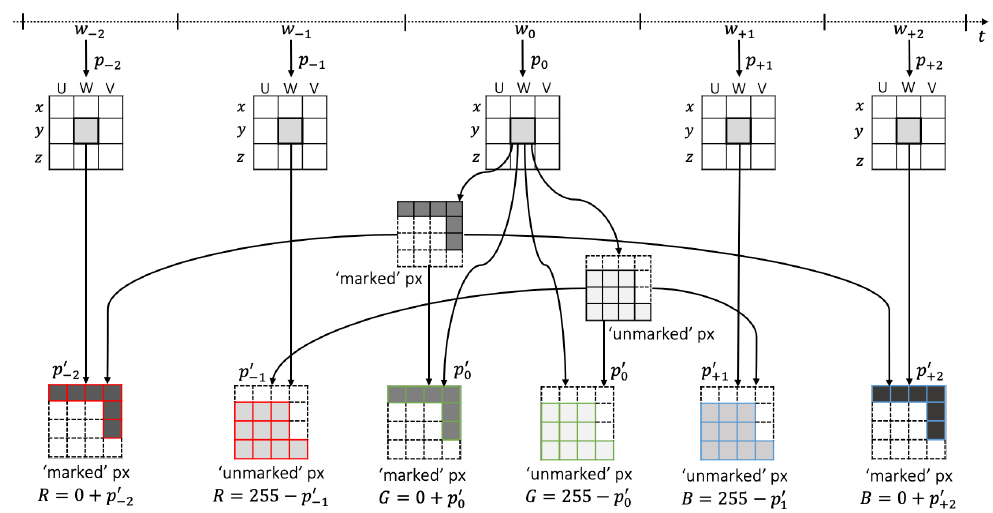
Figure 8. ‘marked’ and ‘unmarked’ coloring based on nearby windows.